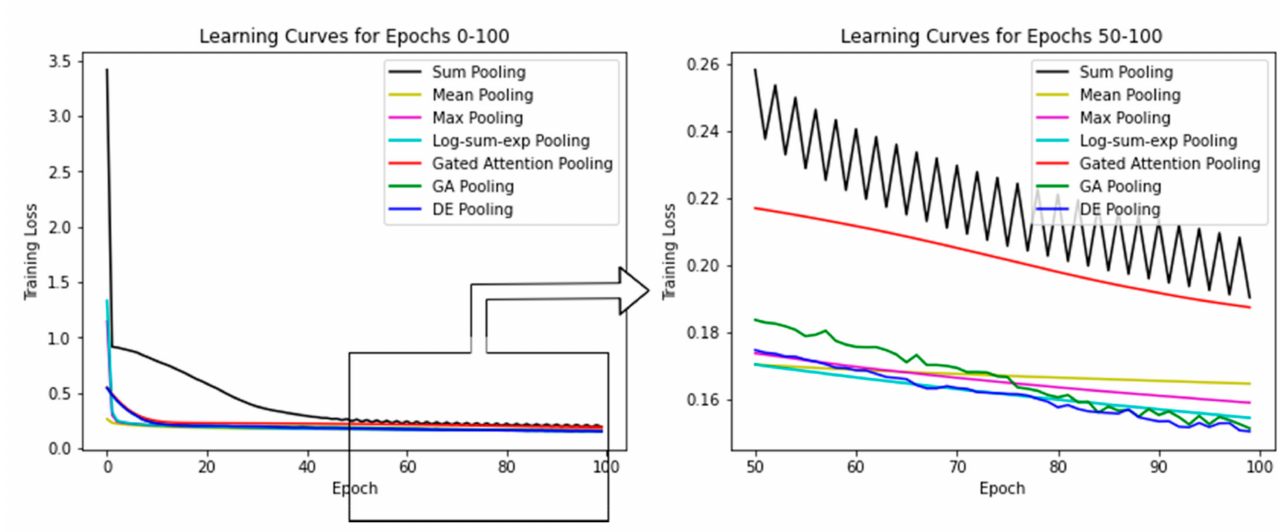
Figure 7. Learning curves.